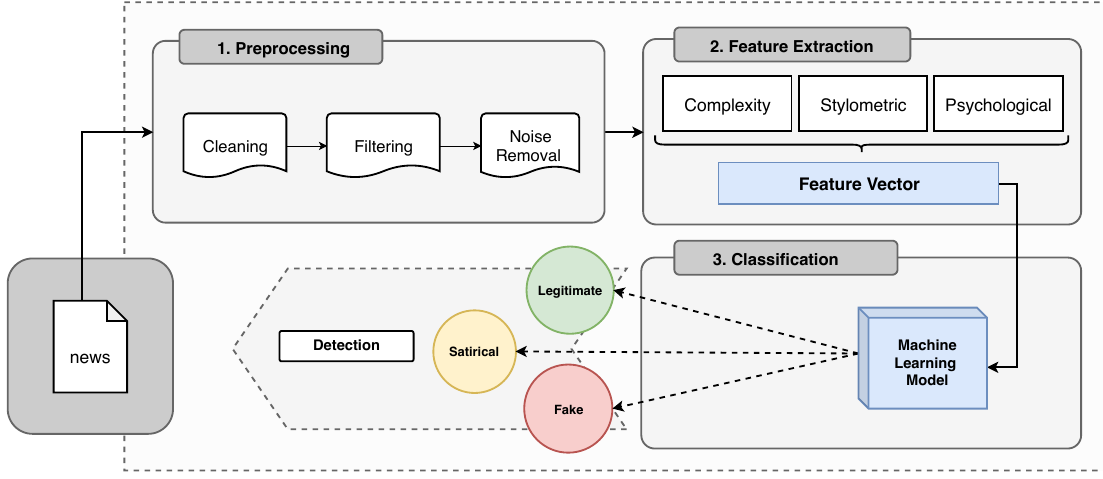
Figure 1. Overview of pipeline to detect news articles among fake, legitimate, and satirical using language-independent